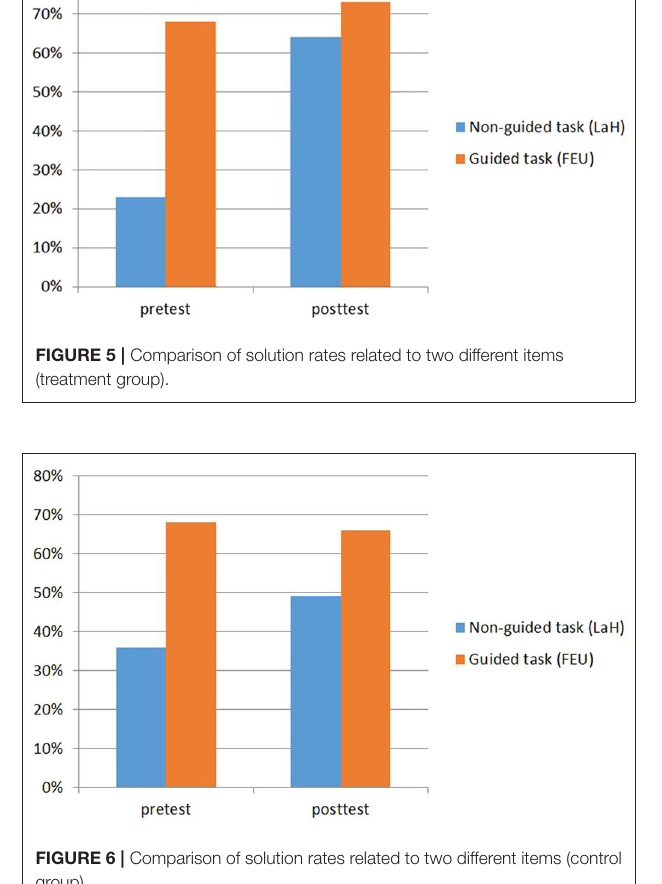
(corrected in the sense of Morris, 2008) indicated a medium effect size of d = 0.59. The findings related to the prediction of the 3- months-delayed follow-up test result were similar (see Table 3 ), whereas in this case the test condition was not